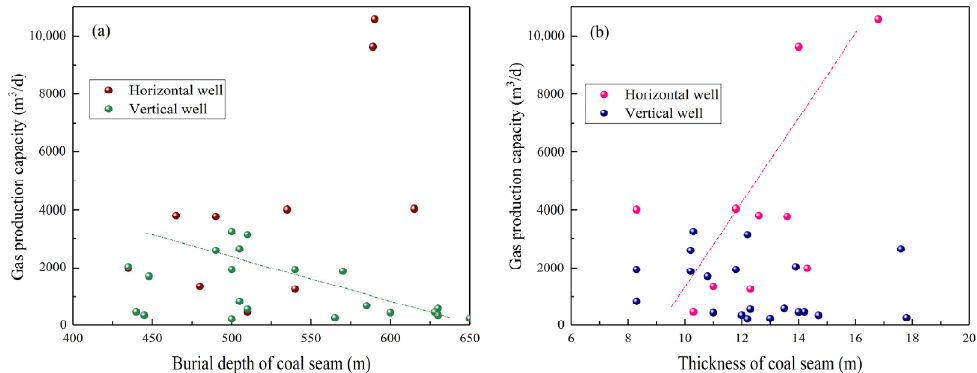
Figure 9. The relationship between gas production and burial depth, thickness of coal seam: ( a ) burial depth of coal seam; ( b ) thickness of coal seam.